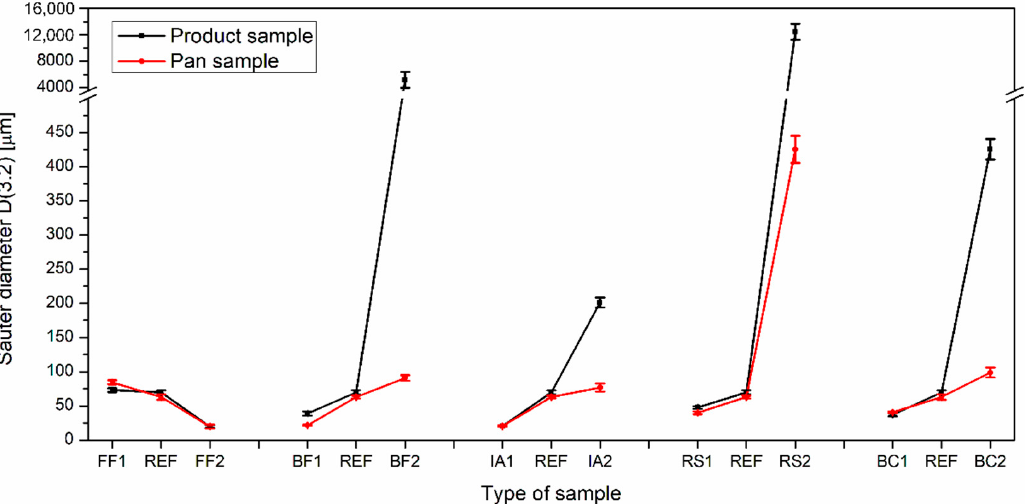
Figure 12. Influence of the operating parameters on the D(3.2) diameter.